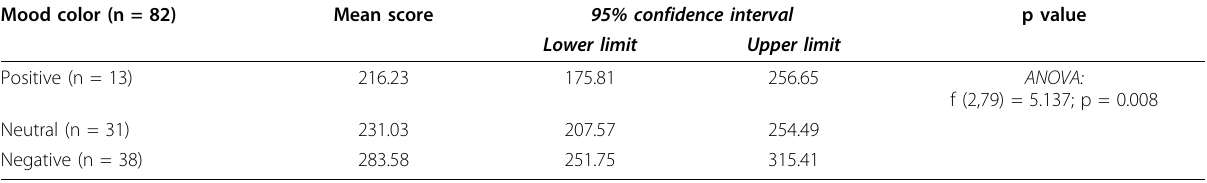
Table 5 Association between pre-HT quality of life score and pre-HT mood color choice